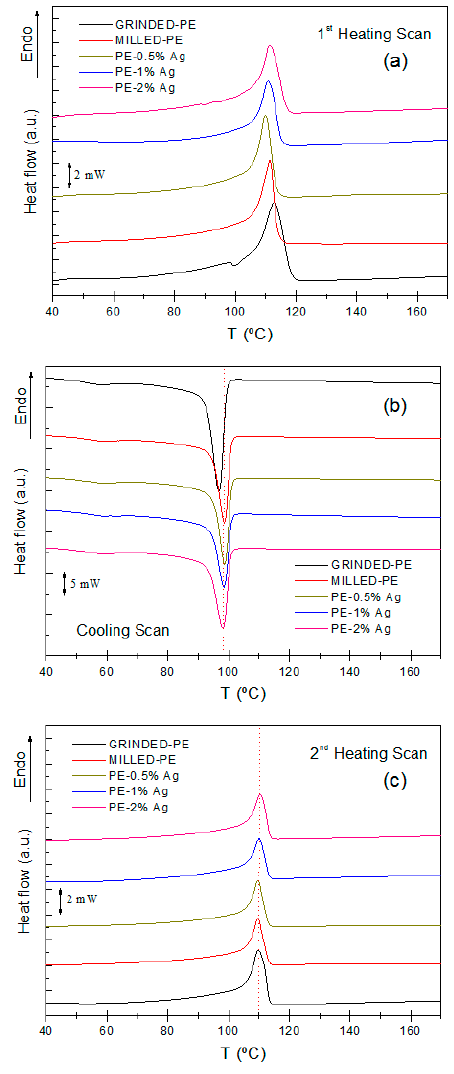
Figure 2. DSC traces corresponding to the first heating scan ( a ); cooling scan ( b ) and second heating scan ( c ).